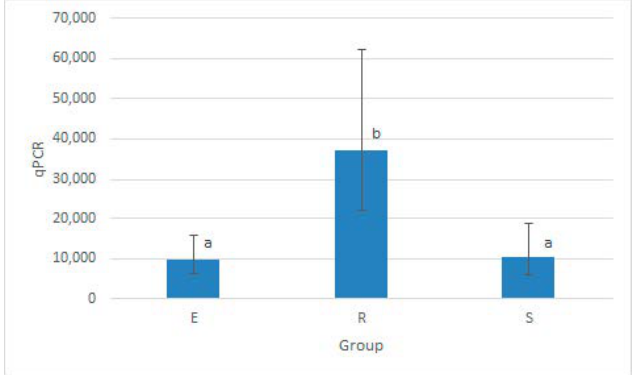
Figure 4. Mycobacteria load comparison detected by qPCR (cp DNA) examination in three clusters. Figure interpretation. CFU = colony-forming units, Cluster E = faeces and animals’ samples, Cluster R = peat and plant material, Cluster S = soil and water sediments. The columns represent geometric means of qPCR; vertical bars correspond to 95% confidence intervals of these means. Letters above columns denote statistically significant differences ( p < 0.05 at least) among groups (columns sharing the same letter are not significantly different from each other; columns that have no letter in common are significantly different from each other).